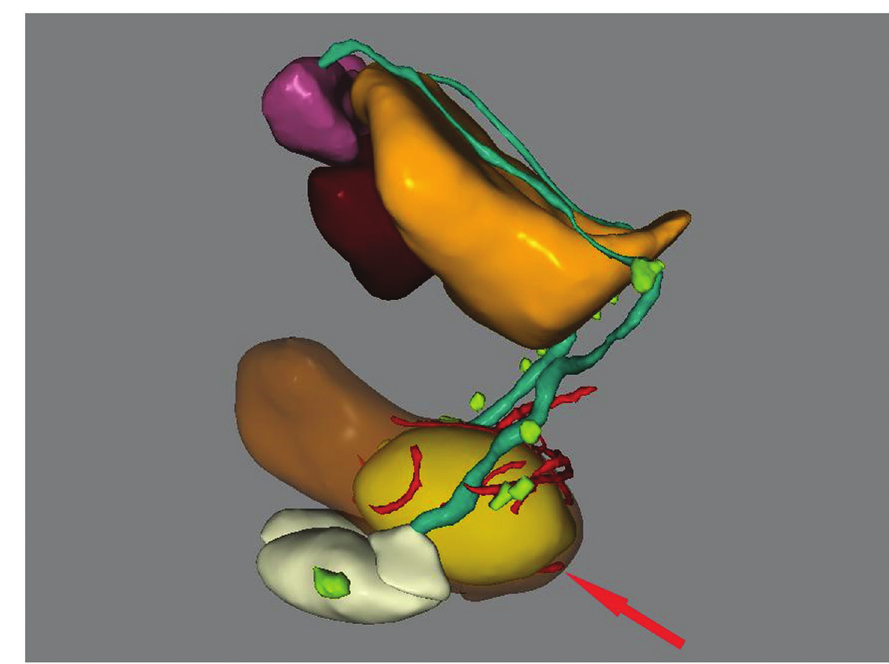
Figure 2. Spiral CT 3-D image of a mass of 4.9 × 3.5 cm found in the cavernous body of the penis root.